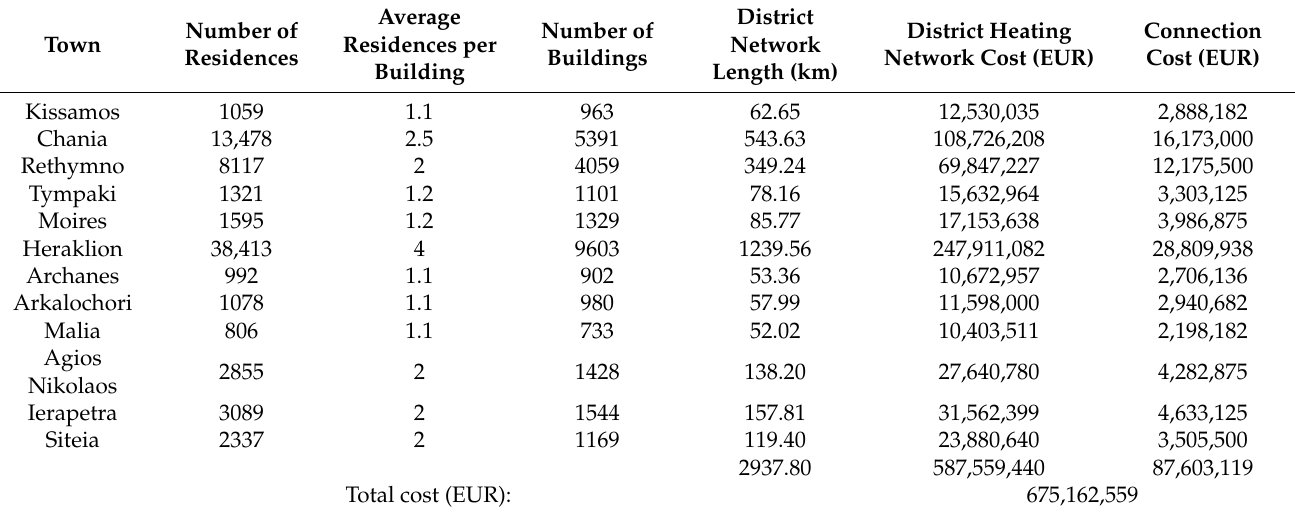
Table 7. Analysis of the district heating network construction